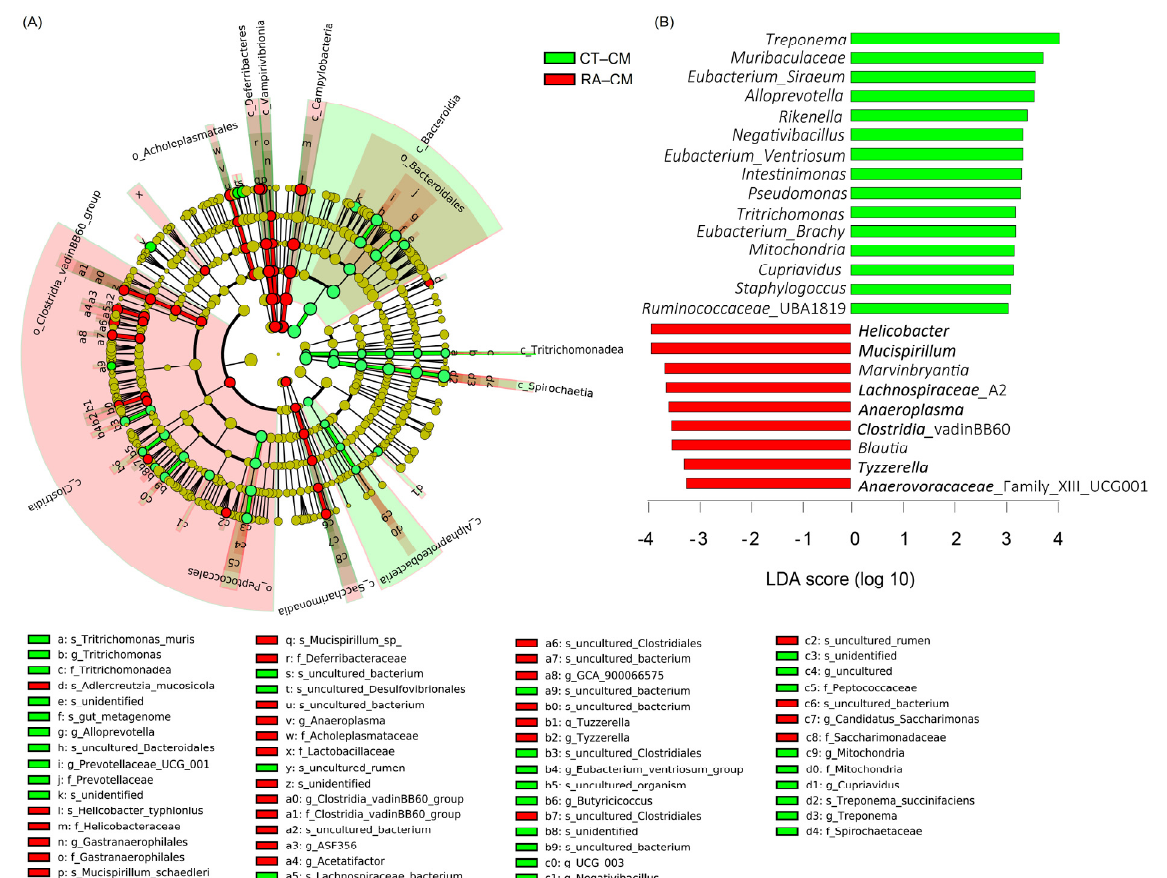
Figure 4. LEfSe analysis of cecal mucosa microbiome in healthy control and RA mouse samples. ( A ) Cladogram constructed by LEfSe indicating alternations between healthy control and RA samples. Regions in green indicate taxa enriched in healthy controls and regions in red indicate taxa enriched in RA mice. The bottom of the cladogram shows the differing taxa. ( B ) LDA scores are described in a bar graph.